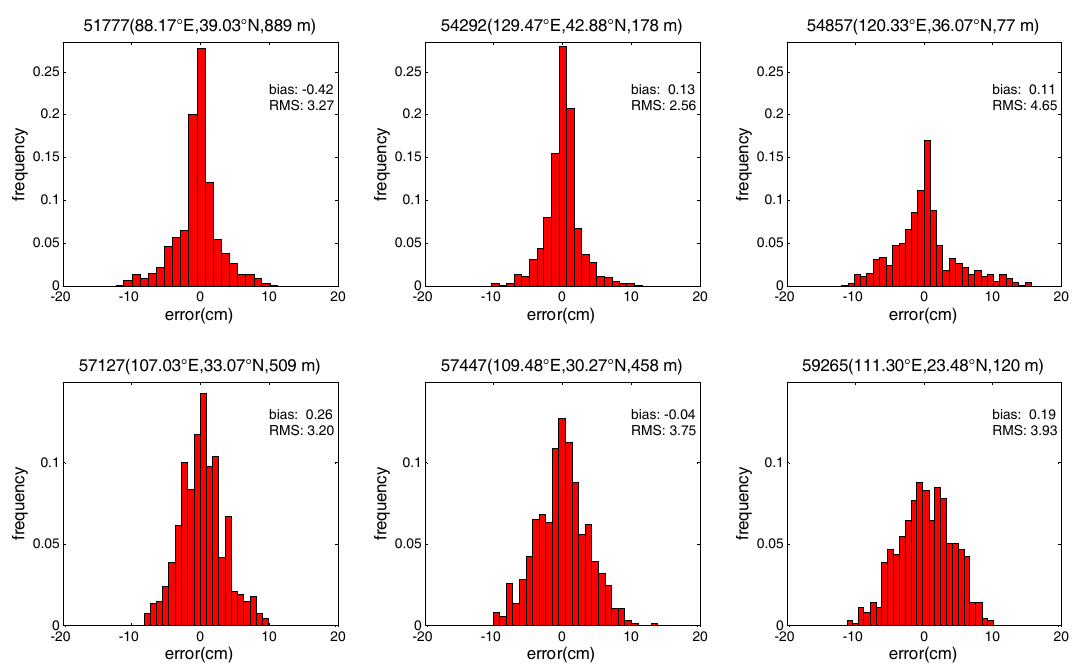
Figure 5. Frequency histograms of error distribution for the SAAS_S model at six radiosonde stations.